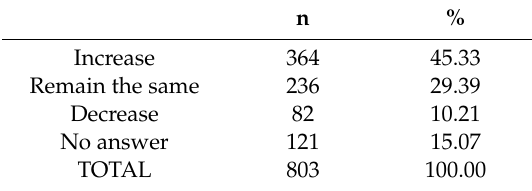
Table 6. Opinions of the respondents about “Aquaculture should in the near future”.